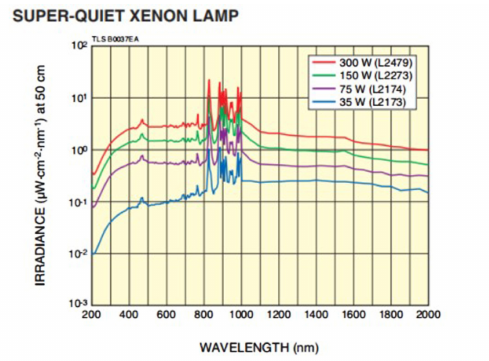
Figure 5. Xenon Lamp Spectral Irradiance (from SOFN INSTRUMENTS CO.).